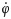
Bicycle roll rate (φ˙) and steer rate (δ˙) versus time.Data from a representative trial (non-cyclist, v = 7.96 m/s) demonstrates that the steer rate (δ˙) lags and is correlated to the bicycle roll rate (ϕ˙) during riding.